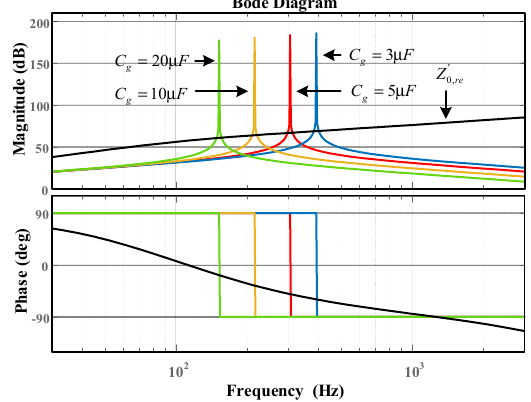
Figure 13. Bode diagram for the zero-sequence impedance of LCL-TFSCI and grid impedance when different k is applied.